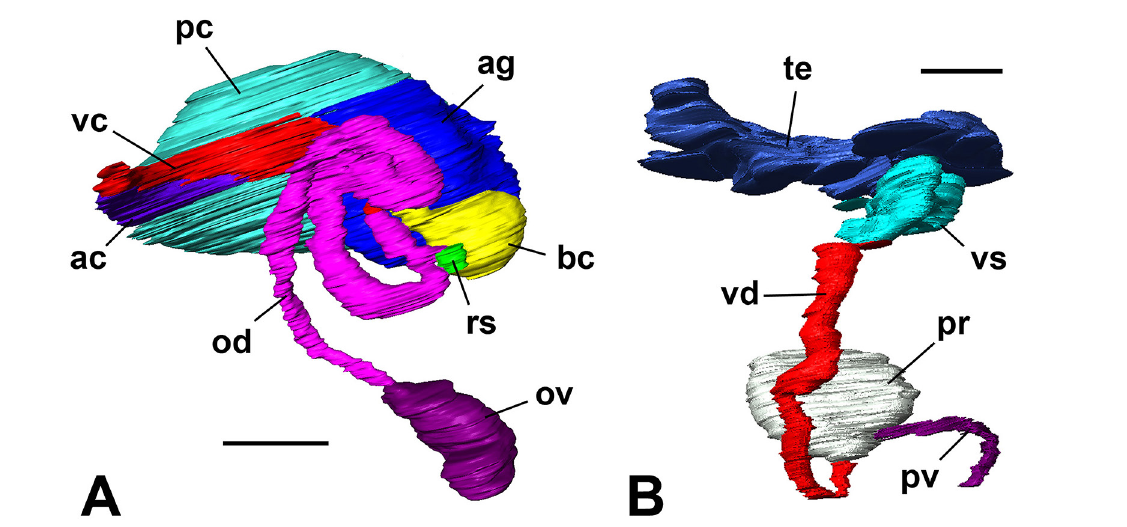
Fig. 9. Genitalia of Catapyrgus jami sp. nov. µCT scans. A . ♀. B . ♂. Abbreviations: ac = anterior capsule gland; ag = albumen gland; bc = bursa copulatrix; od = oviduct; ov = ovary; pc = posterior capsule gland; pr = prostate; pv = pallial vas deferens; rs = receptaculum seminis; te = testis; vc = ventral channel; vd = vas deferens; vs = vesicula seminalis. Scale bars = 50 µm.